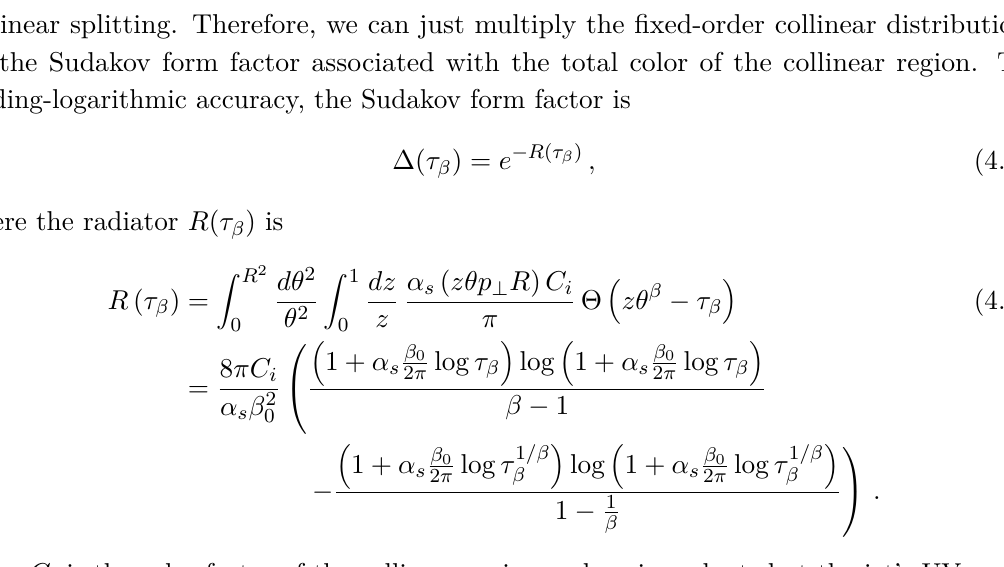
Figure 5 . Distribution of the Les Houches angularity λ 0 . 5 measured about the WTA axis, for quark- flavor. Different curves correspond to different initiating high-energy processes. Left: distributions from Pythia8 simulation. Right: distributions from our simple analytic